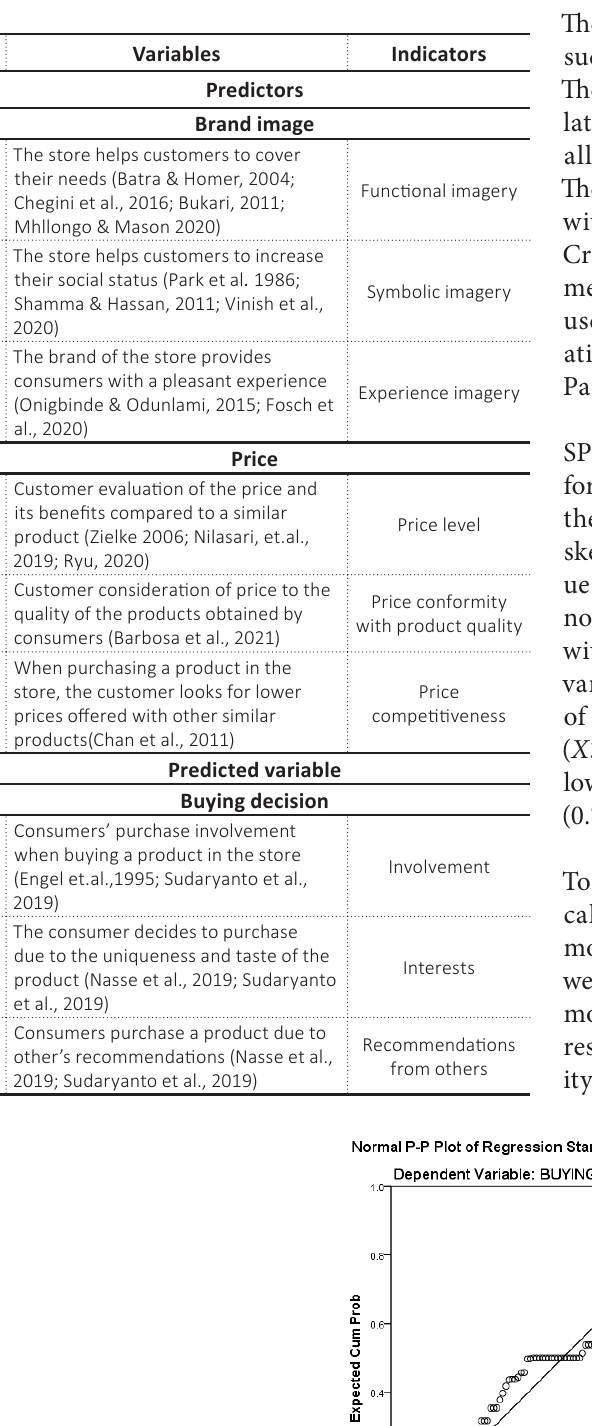
Table 1 (cont.). Definition of